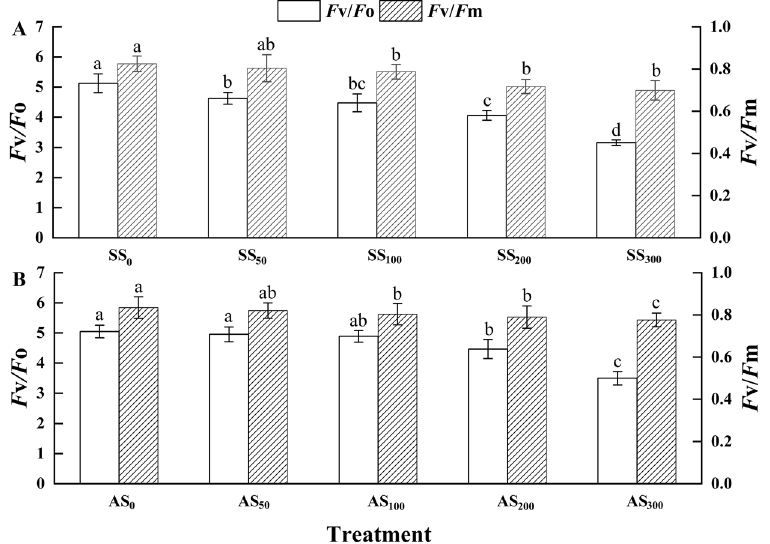
Figure 3. Effects of ( A ) NaCl and ( B ) NaHCO 3 on the F v /F m and F v /F o values of Goji berry after 20 days of treatment with different concentrations. Values are represented as the mean ± SE (n = 5). Abbreviations: Fv/Fm: maximum quantum yield of electron transfer of PSII, Fv/Fo: activity of the water-splitting